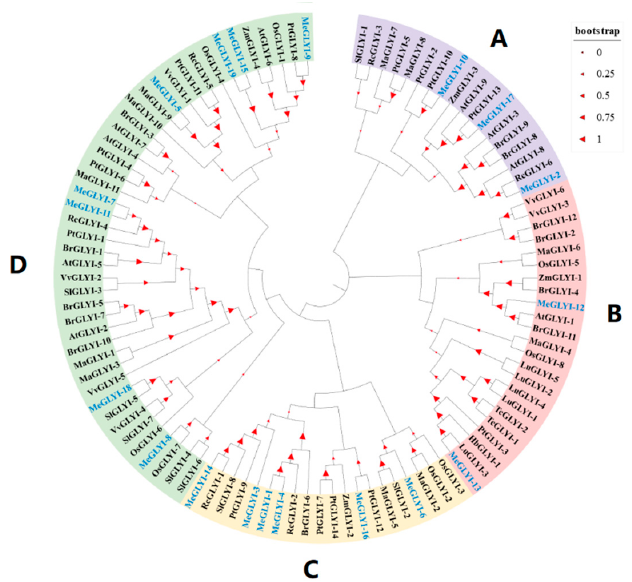
Figure 2. Phylogenetic tree of the GLYIs in cassava and other species. Me, Manihot esculenta ; At, Arabidopsis thaliana ; OS, Oryza sativa ; Rc, Ricinus communis ; Lu, Linum usitatissimum ; Vv, Vitis vinifera ; Br, Brassica rapa ; Pt, Populus trichocarpa ; Ma, Musa acuminata ; Zm, Zea mays ; Sl, Solanum lycopersicum ; Tc, Theobroma cacao ; and Hb, Hevea brasiliensis .